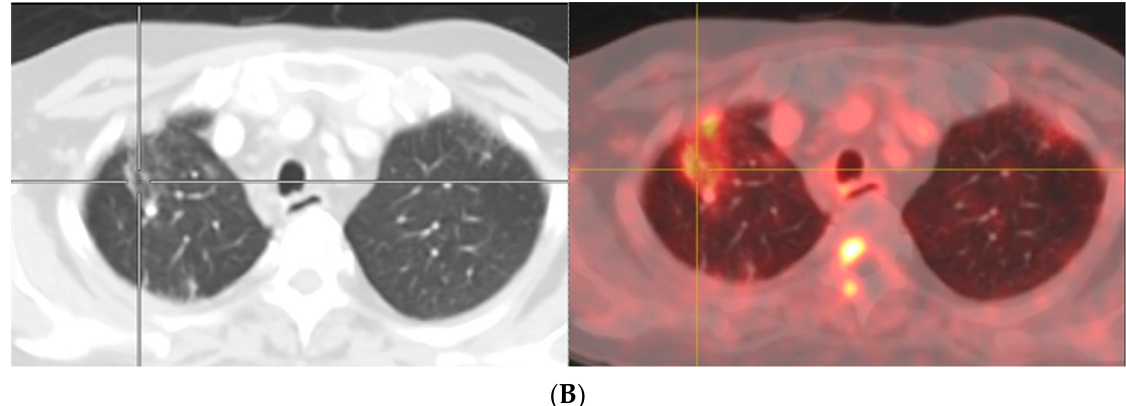
Figure 5. A 75-year-old man with diagnosed PCa (Gleason score of 4 + 4, initial PSA of 43.12 ng/mL) who underwent 18 F-PSMA PET/CT for initial staging. PET/CT scan reveals PSMA uptake at prostatic bed with multiple osteoblastic metastases at vertebrae. There are few subcentimeter mild PSMA- avid nodes at right lower paratracheal regions (SUVmax of 2.72) which are suspected of reactive nodes ( A ). Transaxial PET/CT in lung window ( B ) revealed increased PSMA uptake associated with reticulonodular infiltration at RUL which was suspected of pulmonary infection. After follow-up imaging, pulmonary lesion was improved, and mediastinal nodes revealed no significant change in size but no longer observable PSMA uptake.